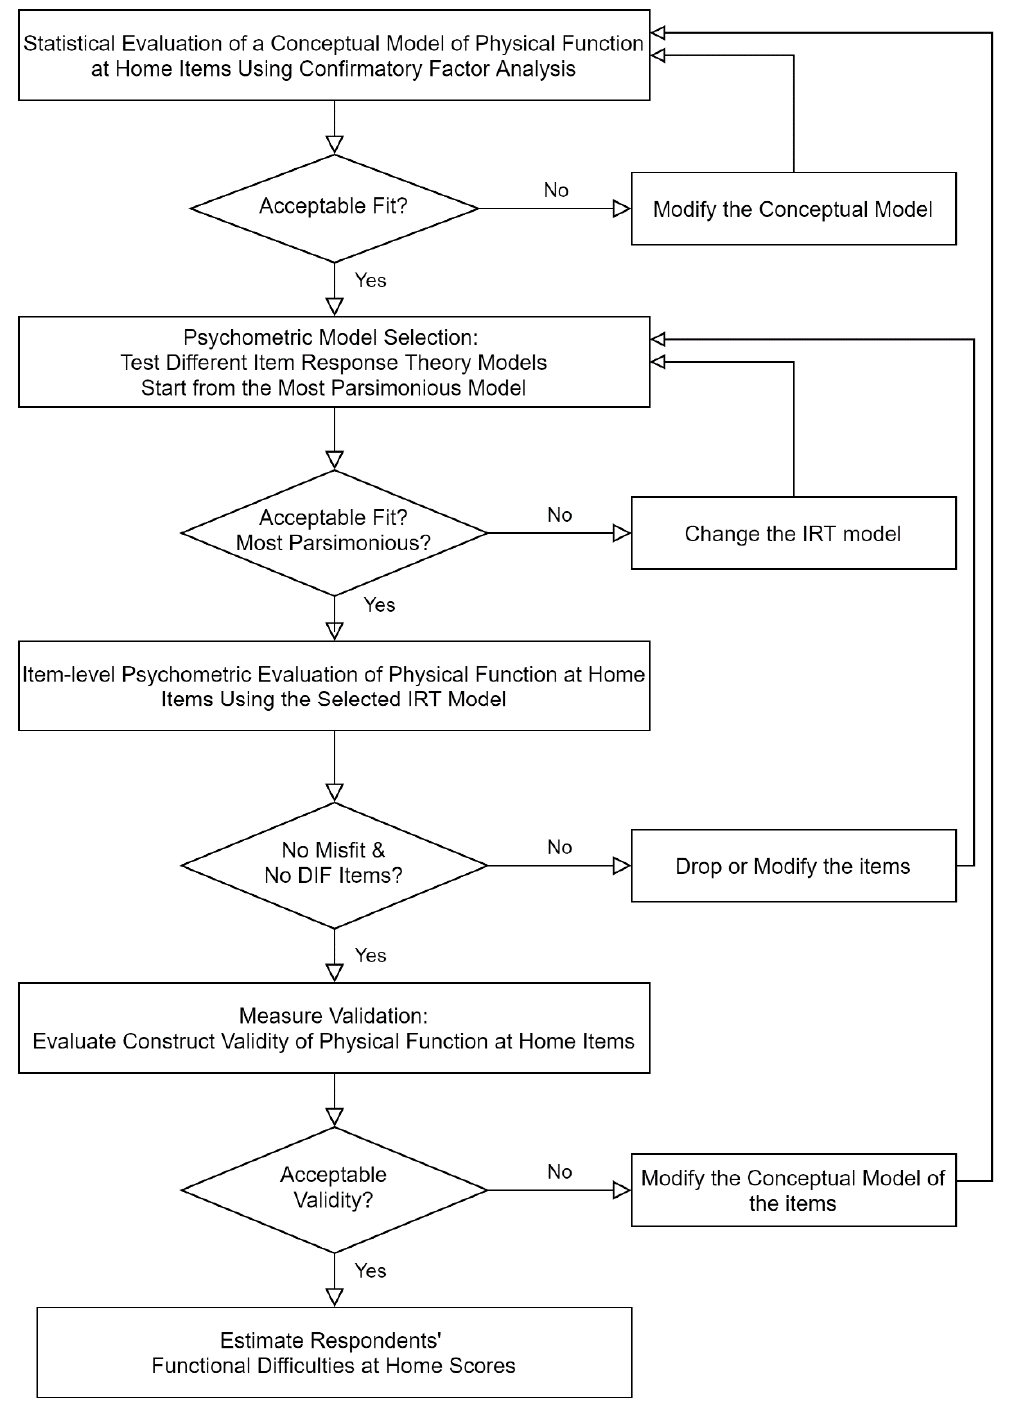
Figure 1. Model Selection and Validation Process.